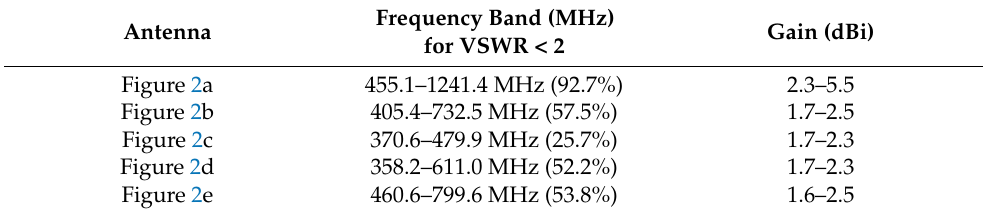
Figure 3. Performance comparison of the five antennas shown in Figure 2: ( a ) input reflection coefficient; ( b ) realized gain. Table 2. Frequency band and gain comparison for the results in Figure 3.